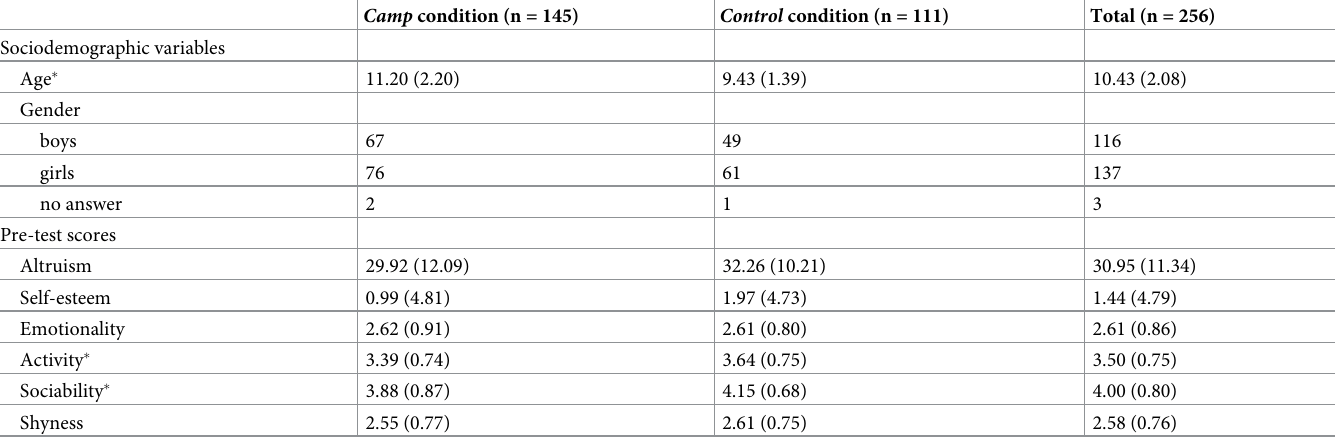
Table 1. Characteristics of the sample by groups (camp vs